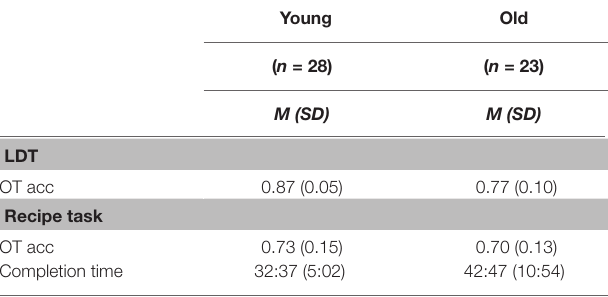
TABLE 5 | Ongoing task accuracy and completion time on PM